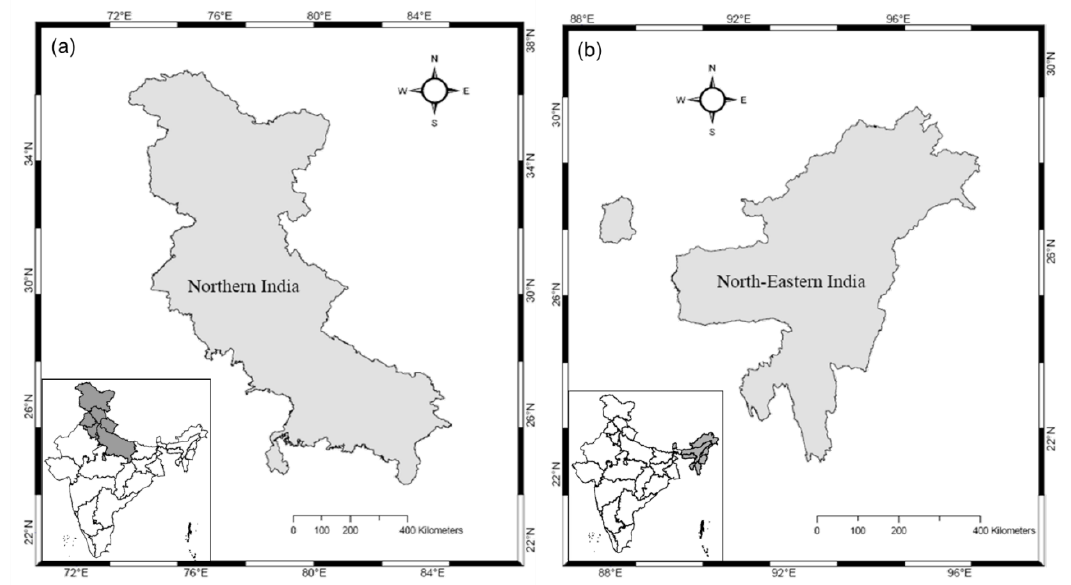
Figure 1. The location map of ( a ) Northern India (NI) and ( b ) North-Eastern India. According to Koppen’s classification, NI consists of climatically diverse regions. The temperature on the plains in NI goes above 35 ◦ C during summer and becomes below 5 ◦ C during winter. Some states in NI experience below the freezing point during winter, while few states receive heavy snowfall and heavy fogs (Oliver and Wilson, 1987). On the other hand, NEI consists of a humid climate with hot summer (go up to 28 ◦ C) together with mild winters (within 14–16 ◦ C) and severe monsoons [19]. As these two regions comprise many high mountains, so the climate over these regions greatly affected due to the features associated with mountains, such as height. Nevertheless, the surface of the earth has been significantly altered, primarily attributing to humanoid activity since immemorial times. The use of land by humankind led to an observable pattern in the LULC that has a profound effect on the natural environment. The footprint of human activities is